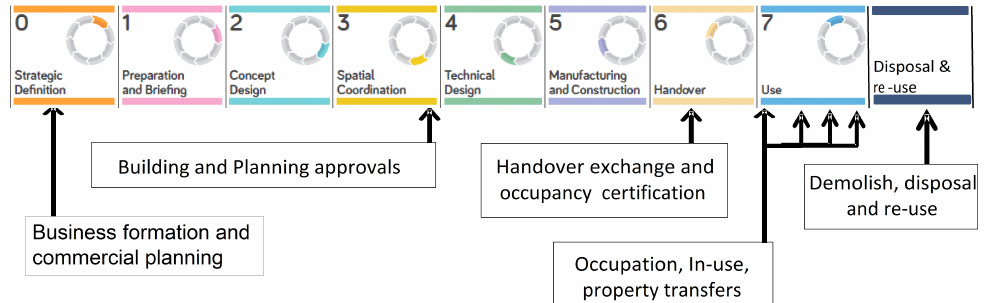
Figure 1. This diagram shows the phases of a typical building’s life-cycle when CO 2 e accounting, reporting, and trading are required. In this diagram, the RIBA Plan of Works serves as a base timeline (© G . M . C . B